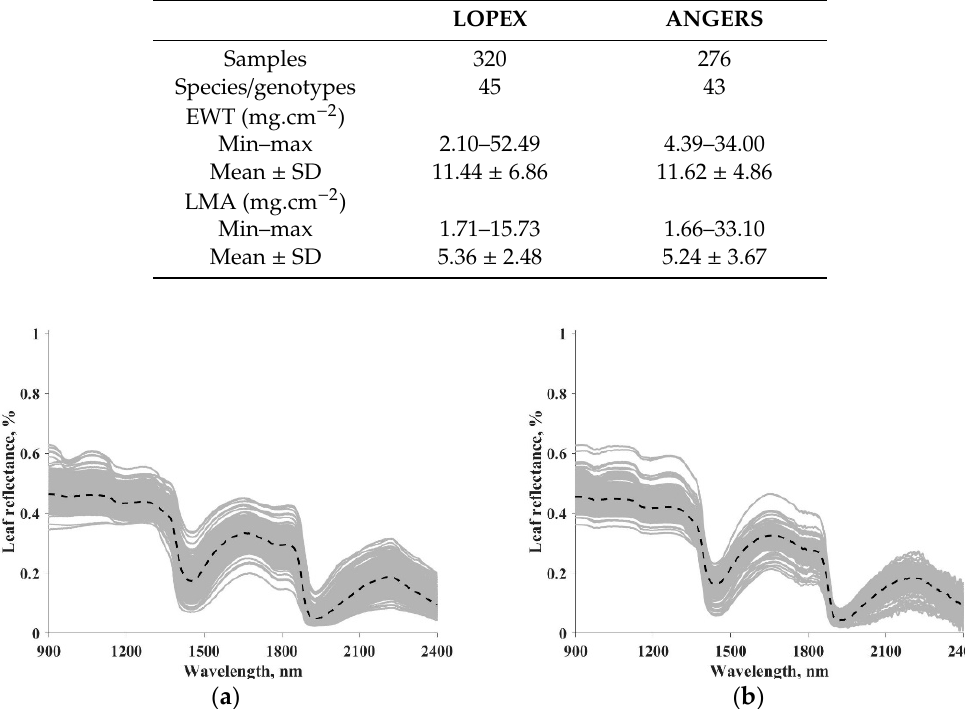
Figure 1. Spectrum of leaf reflectance from the LOPEX ( a ) and ANGERS ( b ) datasets. The dashed dark line represents the median spectrum.